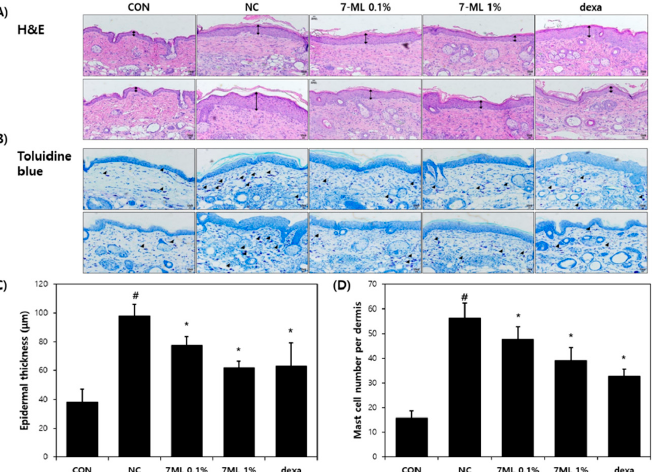
Figure 4. Effects of 7-ML on epidermal thickness and mast cell numbers in the DNCB-induced mouse model. Dorsal skin sections were harvested and stained with H&E ( A ) or toluidine blue ( B ) to evaluate epidermal thicknesses ( C ) and mast cell numbers ( D ). Black up–down arrow indicates epidermis. Black arrow head indicates mast cell. The results are expressed as means ± SDs ( n = 3). # p < 0.05 vs. nontreated controls; * p < 0.05 vs. DNCB negative controls. CON, nontreated control; NC, DNCB-treated negative control; 0.1% or 1% 7-ML, DNCB + 0.1% or 1% 7-ML-treated groups; dexa, DNCB + dexamethasone-treated group.